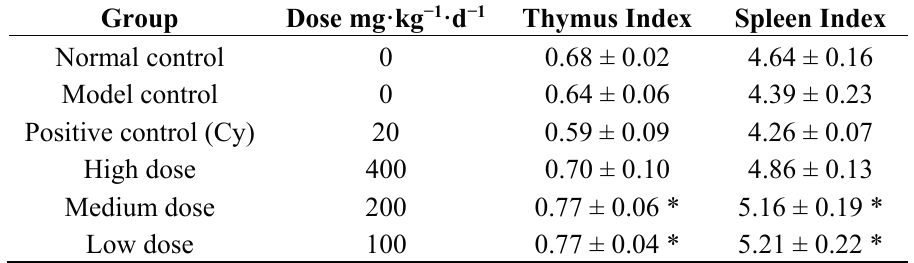
Table 2. Effect of BBP3-1 on the weight of immune organs of mice ( x ± s, n =